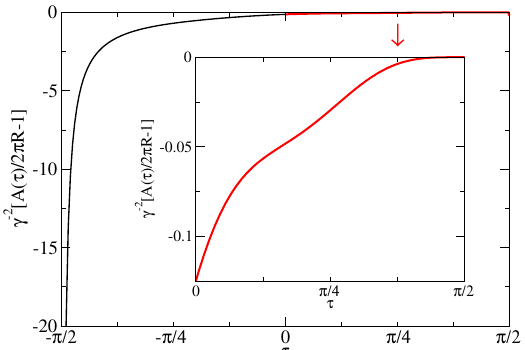
Figure 3 . The future horizon area minus 2 (cid:25)R is depicted as a function of (cid:28) . In the region near , our small (cid:13) approximation breaks down since the coe(cid:14)cient of (cid:13) 2 term becomes too large. (cid:28) = (cid:0) (cid:25) 2 The validity requires that jA ( (cid:28) ) = (2 (cid:25)R ) (cid:0) 1 j (cid:28)